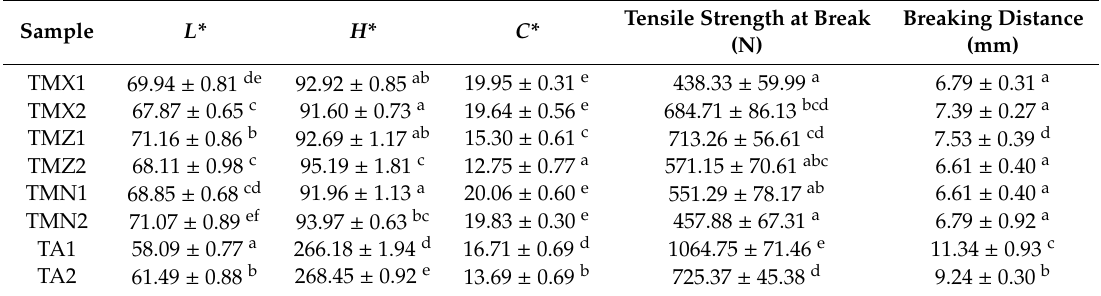
Table 6. Color and mechanical texture parameters of tortillas